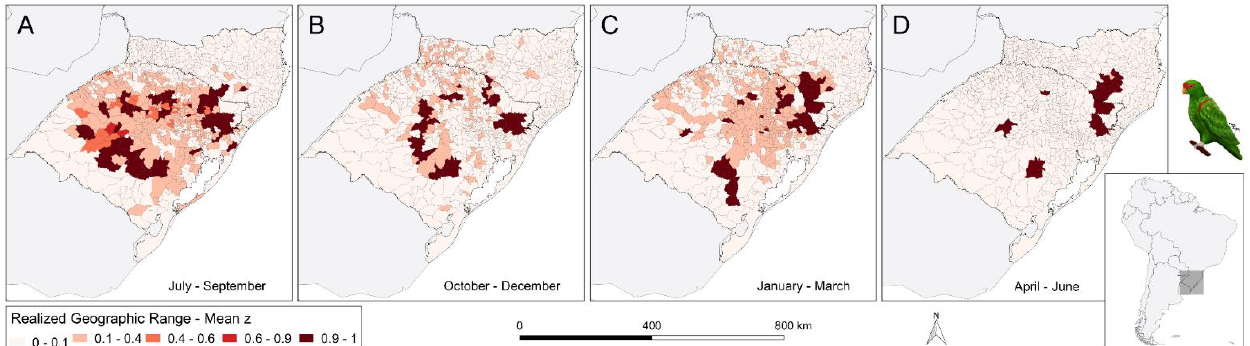
Figure 2. Seasonal variation of the geographic range of the Red-Spectacled Parrot ( Amazona pretrei ) as shown by the mean of the true occupancy state ( 𝑧 ) estimated for each municipality. Each panel represents a trimester, the sequence starting with July–September ( A ), when the species is most dispersed, and proceeds in three-month intervals to October-December ( B ), January-March ( C ) until April–June ( D ), when it aggregates in only a few municipalities. Darker tones of red indicate higher mean 𝑧 ; intermediate tones indicate the highest uncertainty about species presence.